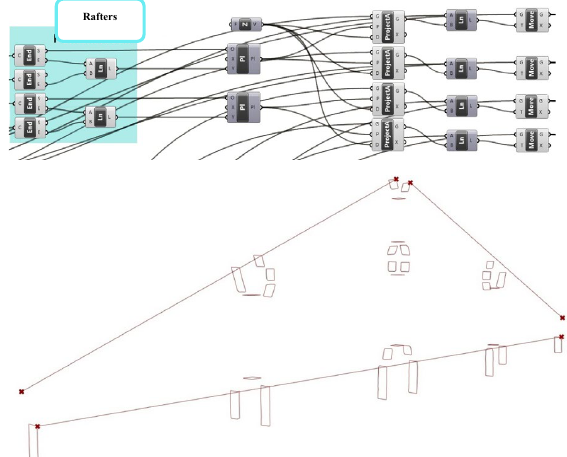
Figure 12: Parts of the algorithm for the rectification of trusses